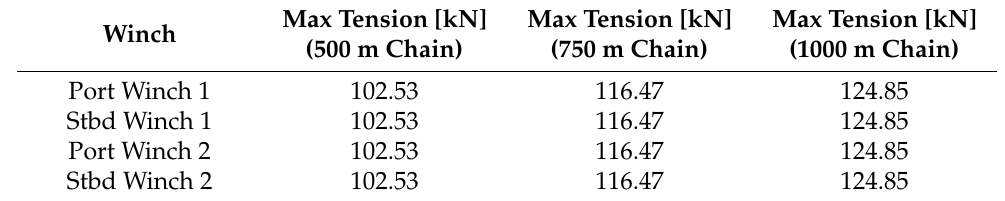
Table 8. Maximum values of the tension of the anchor chains depending on the length of the unwound chain.